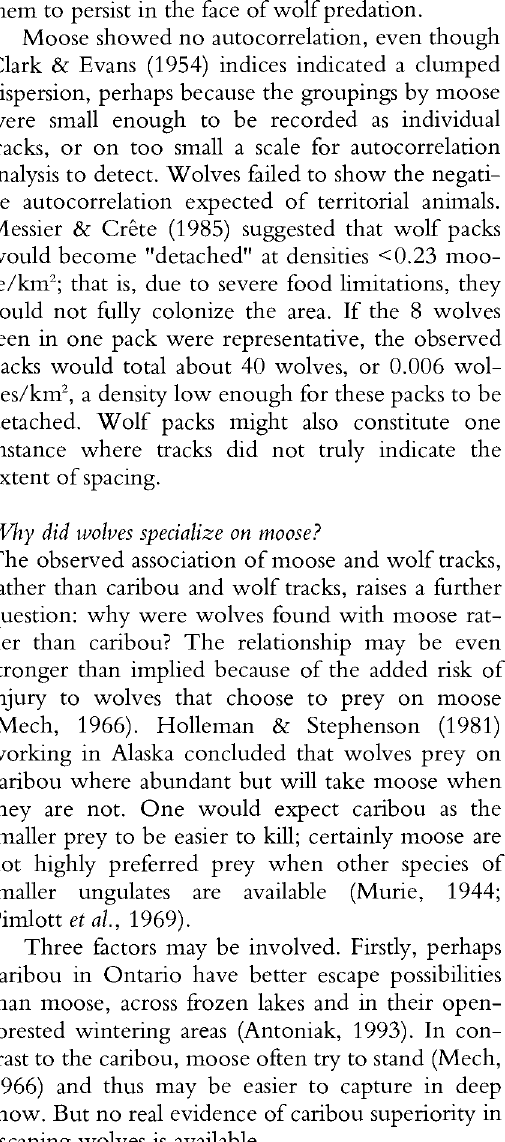
Table 6. Significance of Bonferroni 95% confidence intervals and direction of difference for caribou (C), moose (M), and wolf (P) paired associations during four